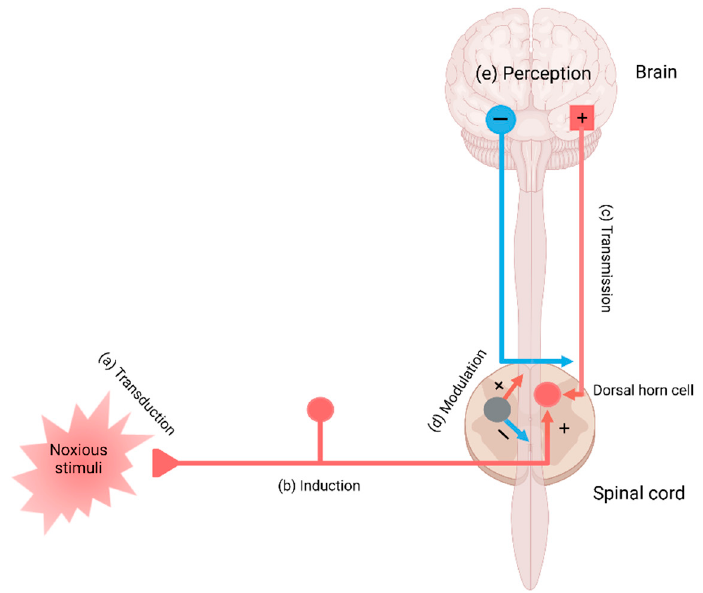
Figure 1. The main components in the pain pathway: ( a ) transduction, ( b ) induction, ( c ) transmission, ( d ) modulation, and ( e ) perception. Created with BioRender.com.